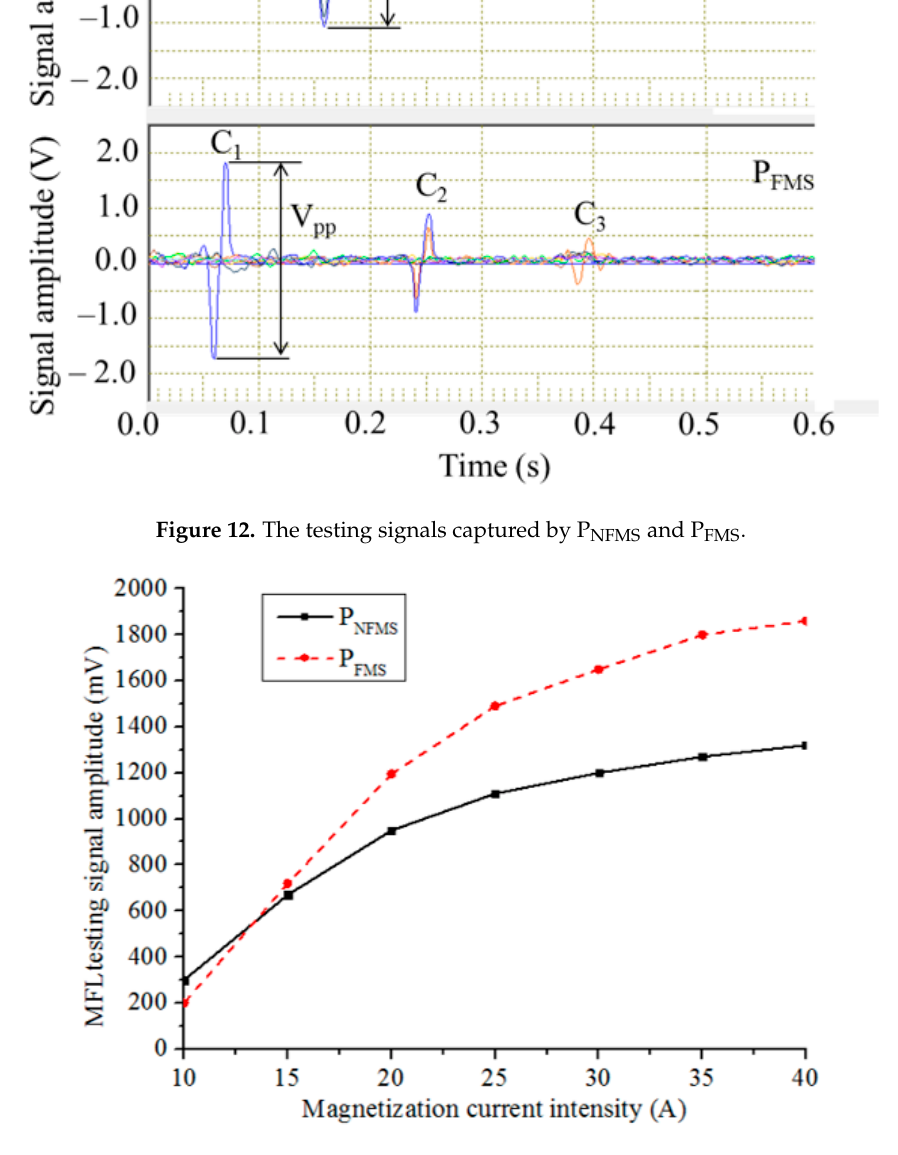
Figure 13. The testing amplitudes captured by P NFMS and P FMS with different